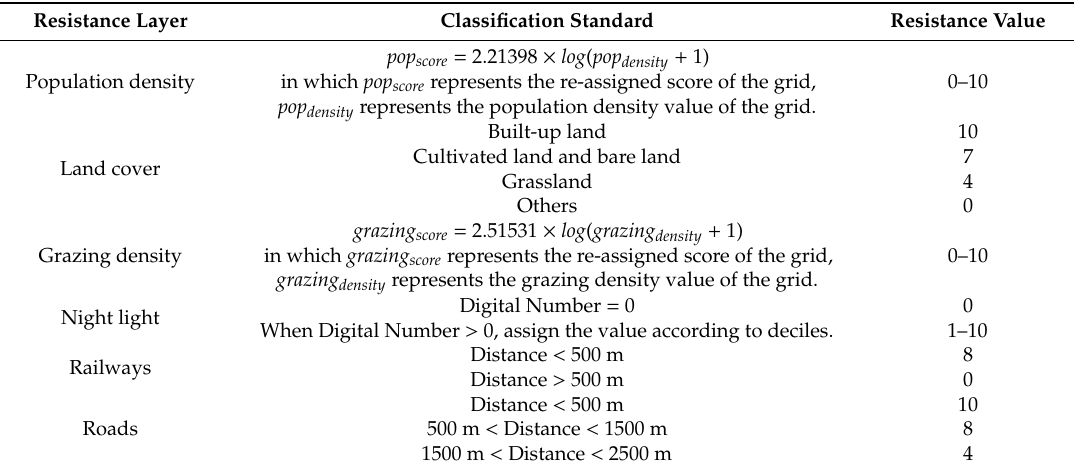
Table 3. Resistance assignment for human